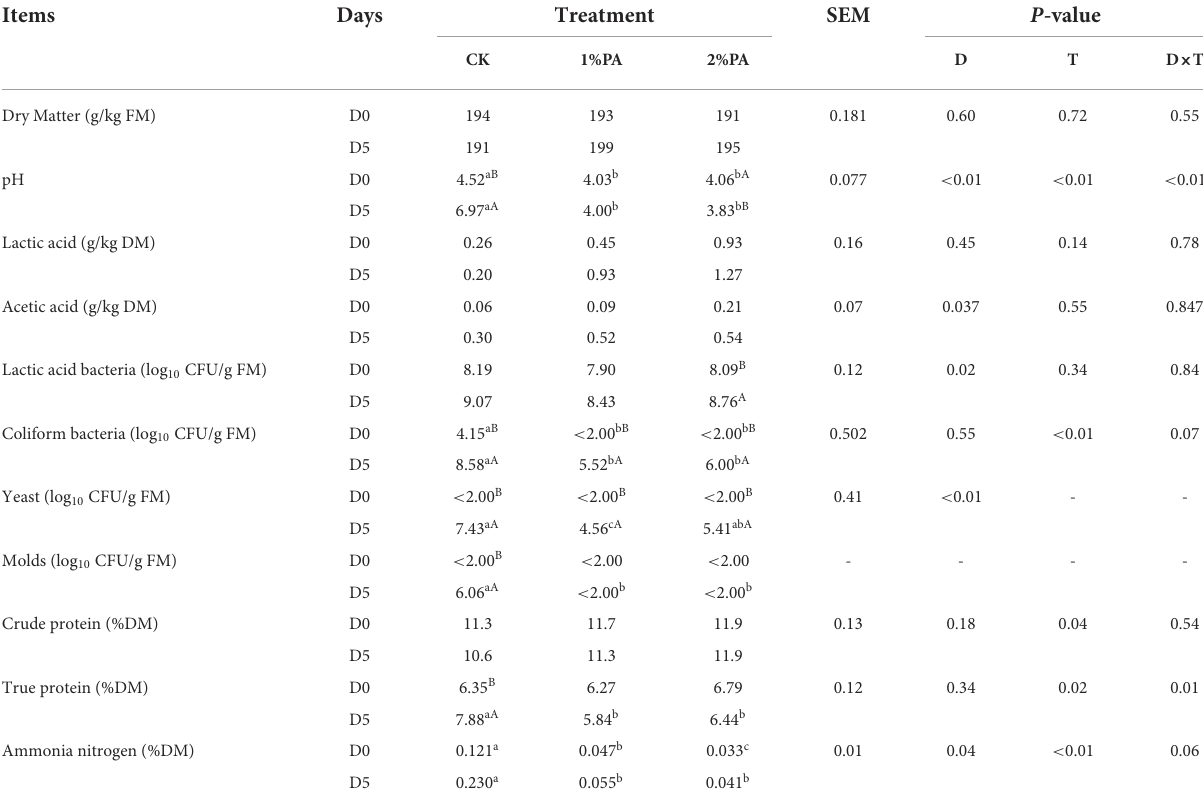
TABLE 2 Chemical compositions and fermentation characteristics of Napier grass with or without PA treatment under aerobic exposure. Items